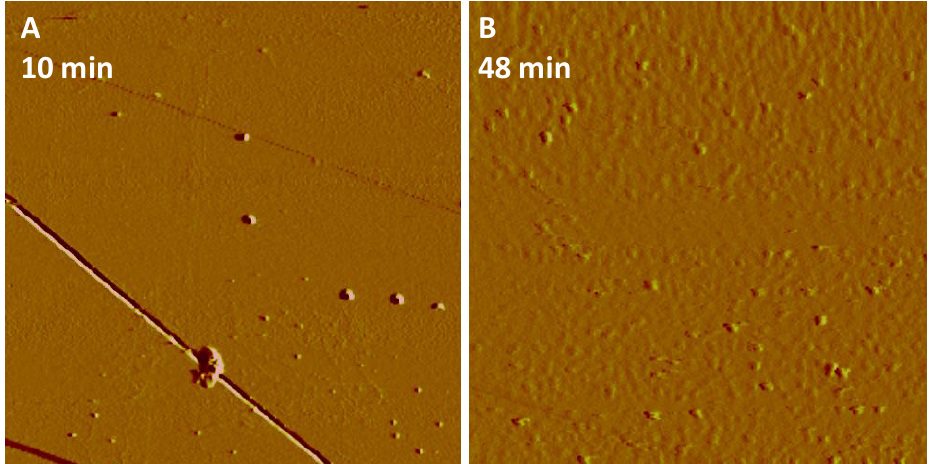
Figure 3. Following ( A ) 10 min, particles initially formed, and after ( B ) 48 min of injecting reaction solution (50 mM NH 4 H 2 PO 4 , pH 2.0), the scan area (5 μm × 5 μm) on hematite was covered with a larger number of the new nucleating particles, compared with 50 mM NH 4 H 2 PO 4 reaction solution at pH 4.5 after the same reaction time in Figure 1I.